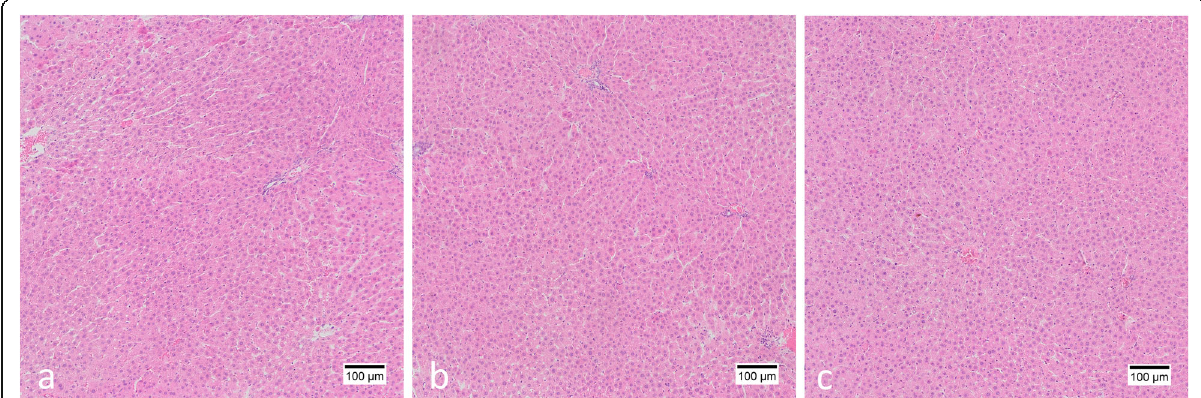
Fig. 5 Histological analysis from liver samples of rats consuming regular chow, fructose, or fructose and fish oil. a Liver histology of CT group. b Liver histology of Fr group. c Liver histology of FOFr